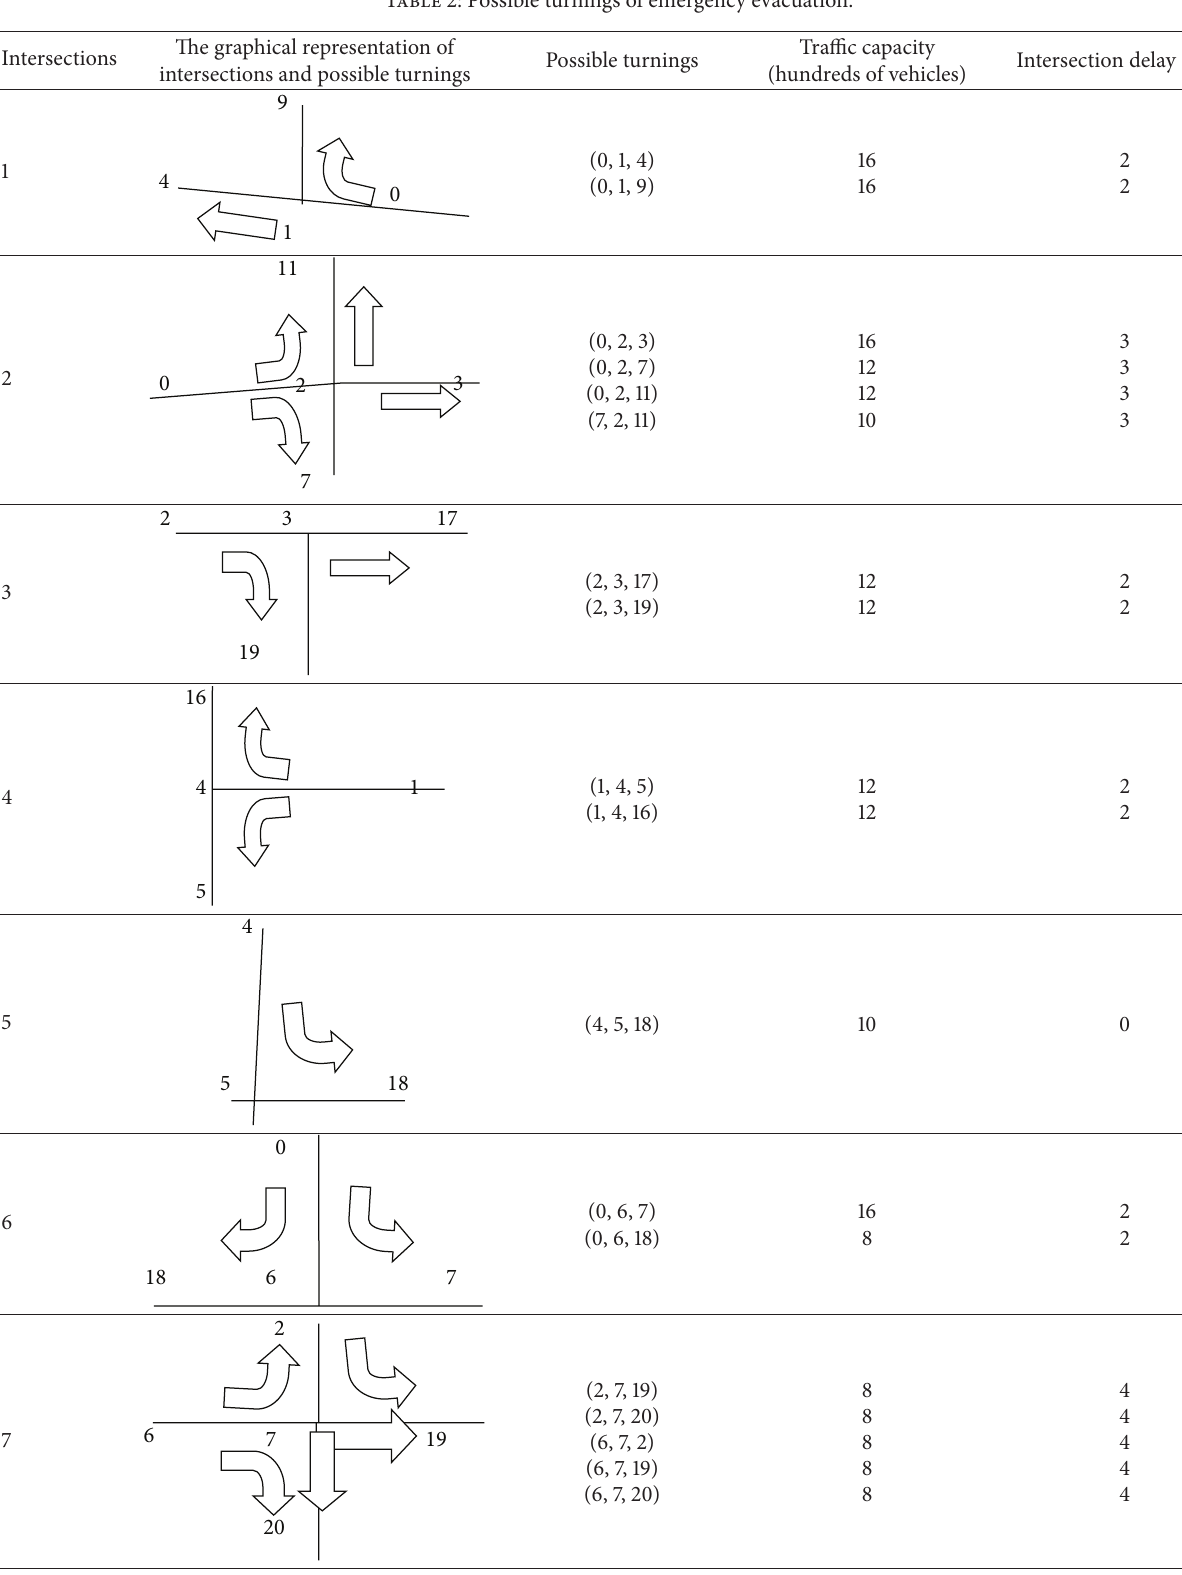
Table 2: Possible turnings of emergency